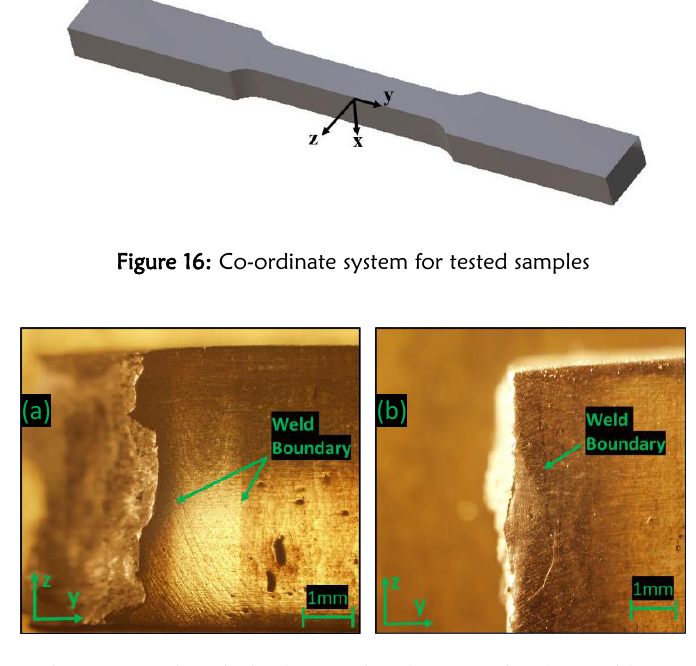
Figure 17: (a) Sample 16A (209.6 J/mm) with the fractured surface outside of its weld zone; (b) Sample 18B (196.8 J/mm) with the fractured surface inside of its